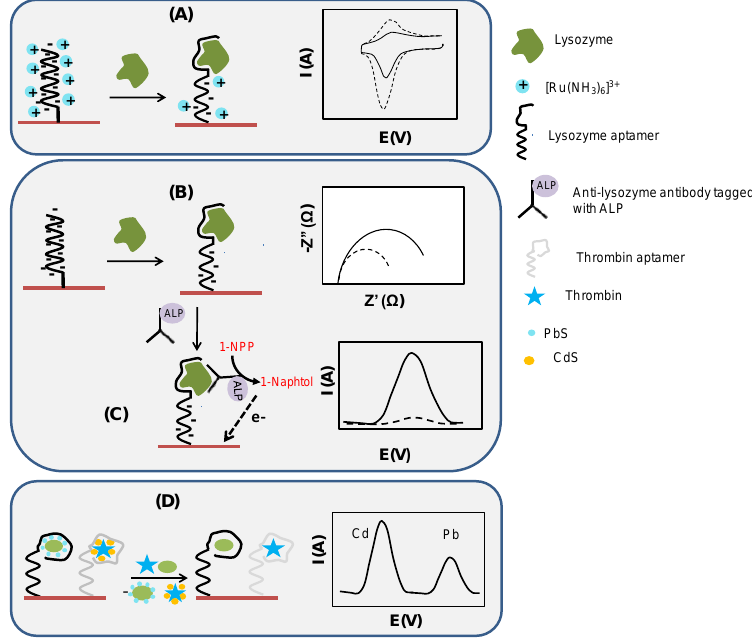
Figure 4. Electrochemical aptasensors’ detection schemes of lysozyme: ( A ) direct assay by recording the conformational changes of surface-linked aptamers upon lysozyme binding, which results in a decrease in electrostatically-bound Ru(NH 3 ) 6 ] 3+ detectable by CV (e.g., as illustrated in [87]); ( B ) formation of the aptamer-lysozyme complex creates a barrier for the electron transfer of (Fe(CN) 6 ] 4−/3− in solution proportional to lysozyme concentration and detectable by EIS [63]; ( C ) sandwich assay for lysozyme analysis using amplification with a lysozyme antibody labeled with alkaline phosphatase [44]; ( D ) competitive assay where free lysozyme in solution displaces quantum dot-tagged lysozyme, previously bound to surface-immobilized aptamer (e.g., as illustrated in [94]).